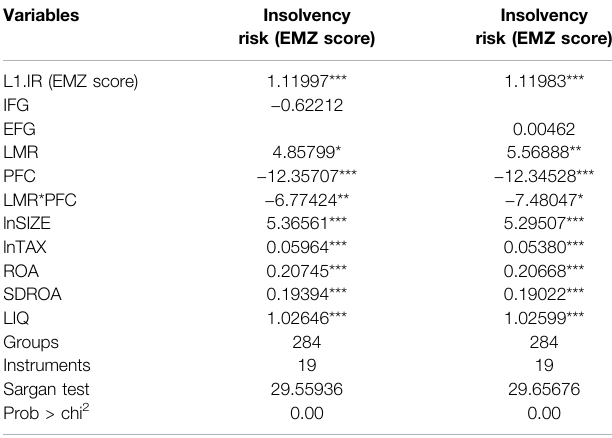
TABLE 11 | Two-step system GMM results.